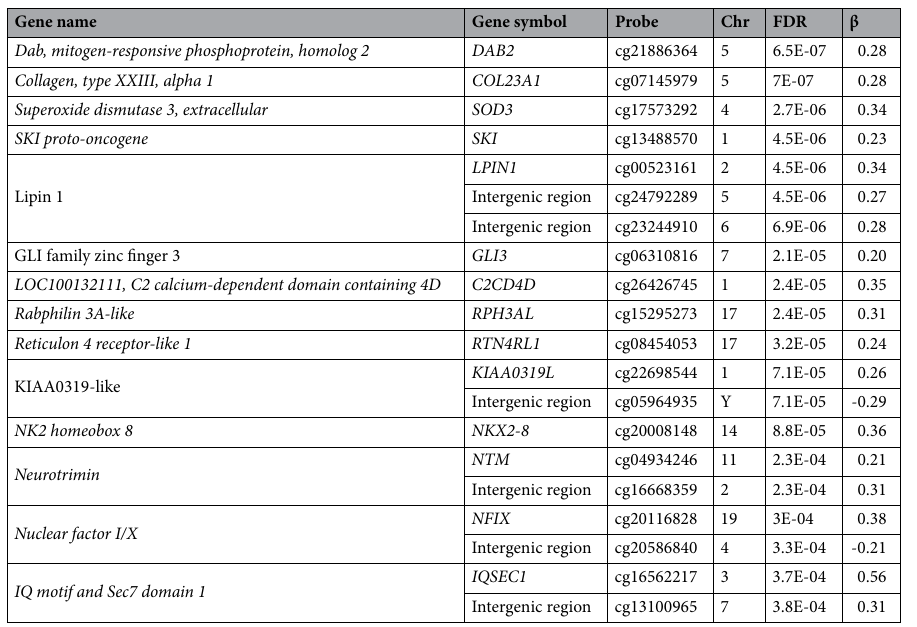
Table 2. DMPs in the group of individuals taking vitamin D supplements and exerting high levels of physical activity. * FDR False discovery rate; Chr chromosome, β beta value